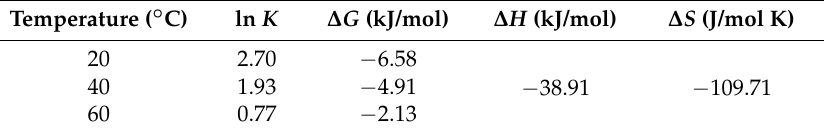
Table 5. Thermodynamic parameters for HCHO adsorption on